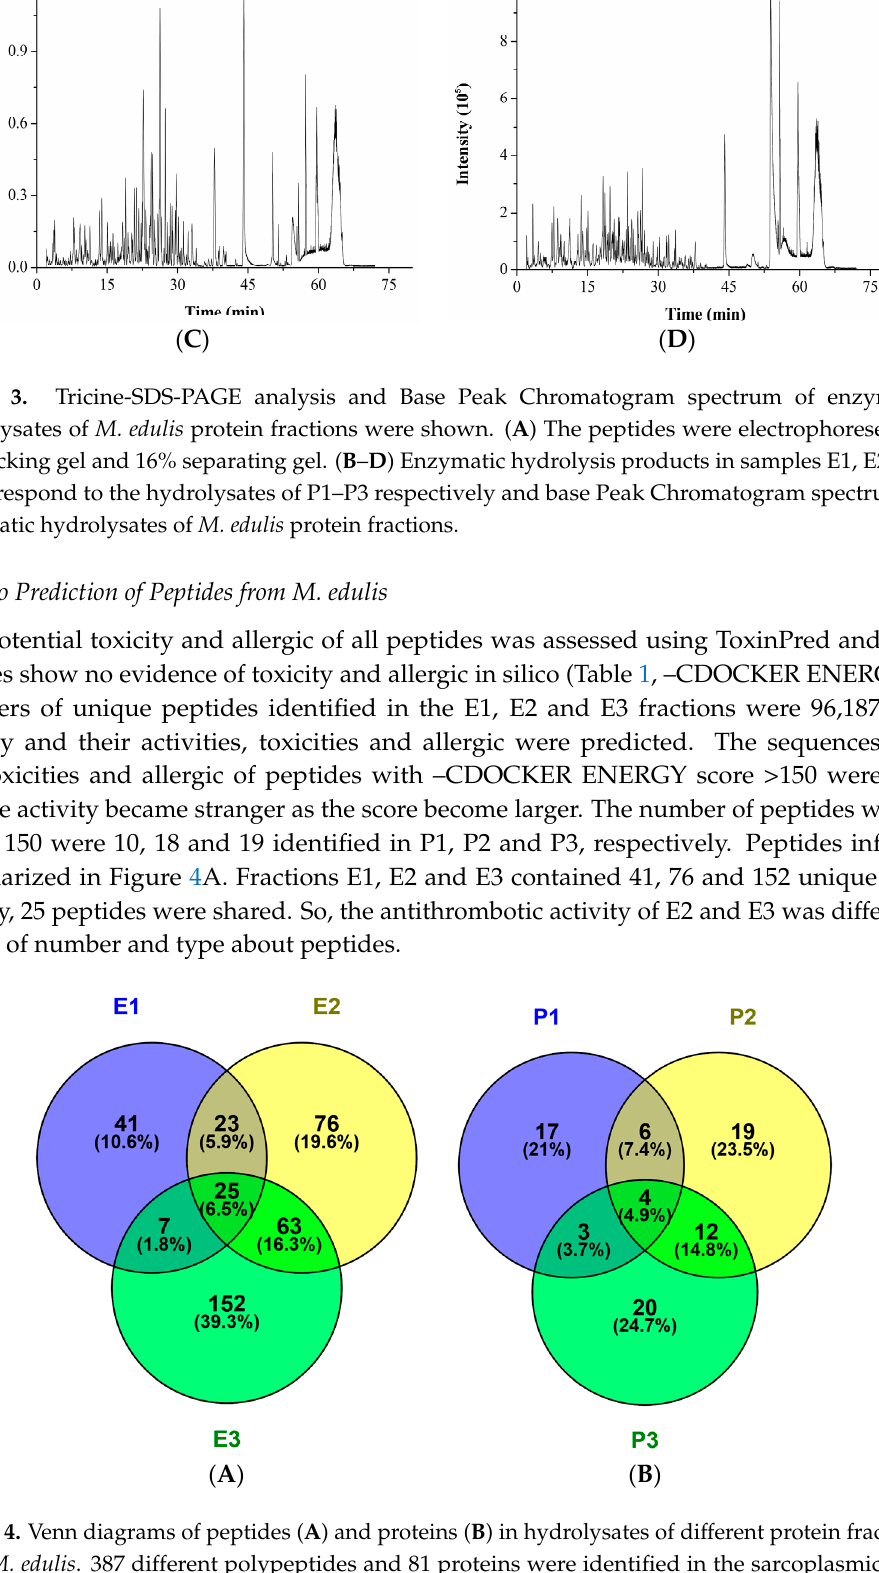
Figure 4. Venn diagrams of peptides ( A ) and proteins ( B ) in hydrolysates of different protein fractions from M. edulis . 387 different polypeptides and 81 proteins were identified in the sarcoplasmic (P1), myofibrillar (P2) and matrix (P3) protein fractions. Venn diagrams were painted with Venny 2.1.0. Enzymatic hydrolysis products named E1, E2 and